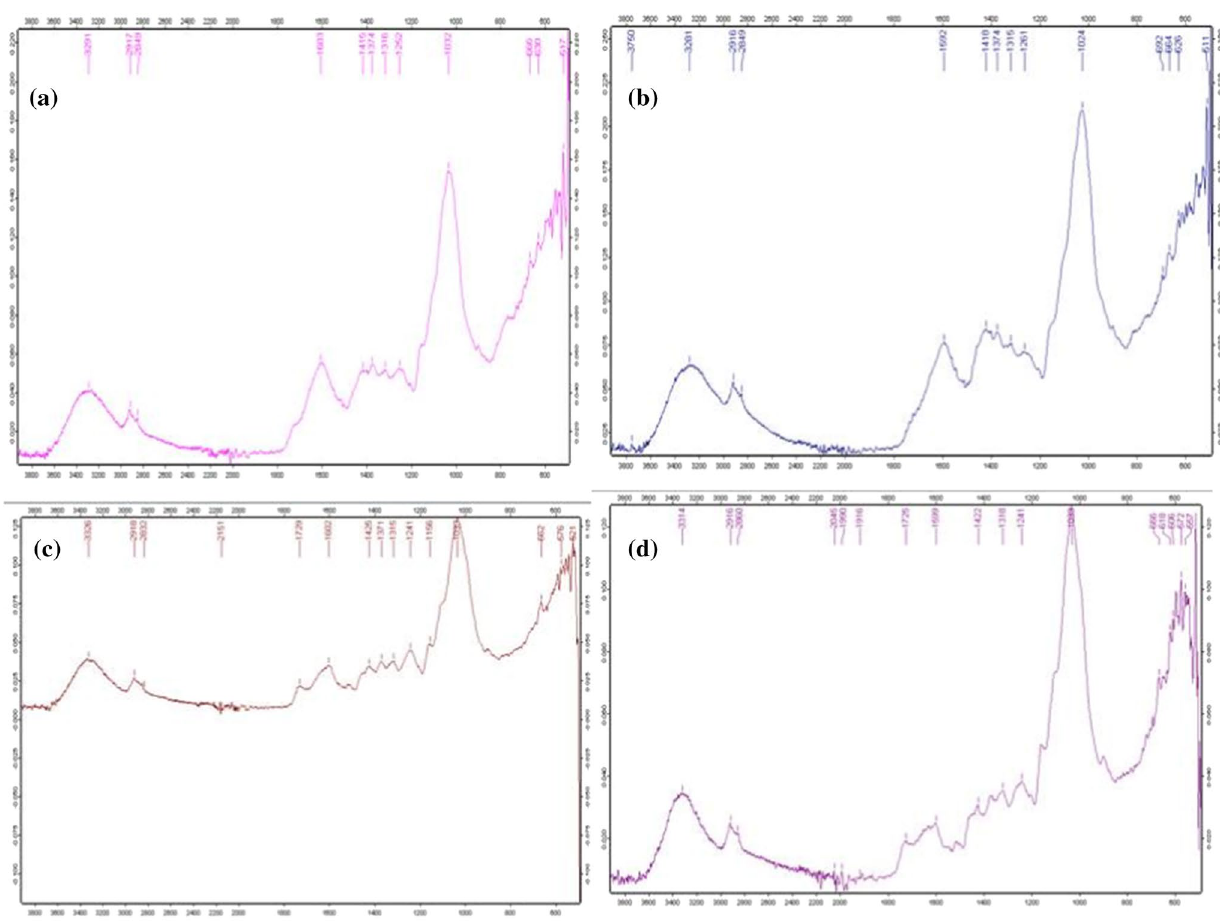
Fig. 1 FTIR spectra of unloaded a and loaded b S. molesta and unloaded (c) and loaded (d) T.